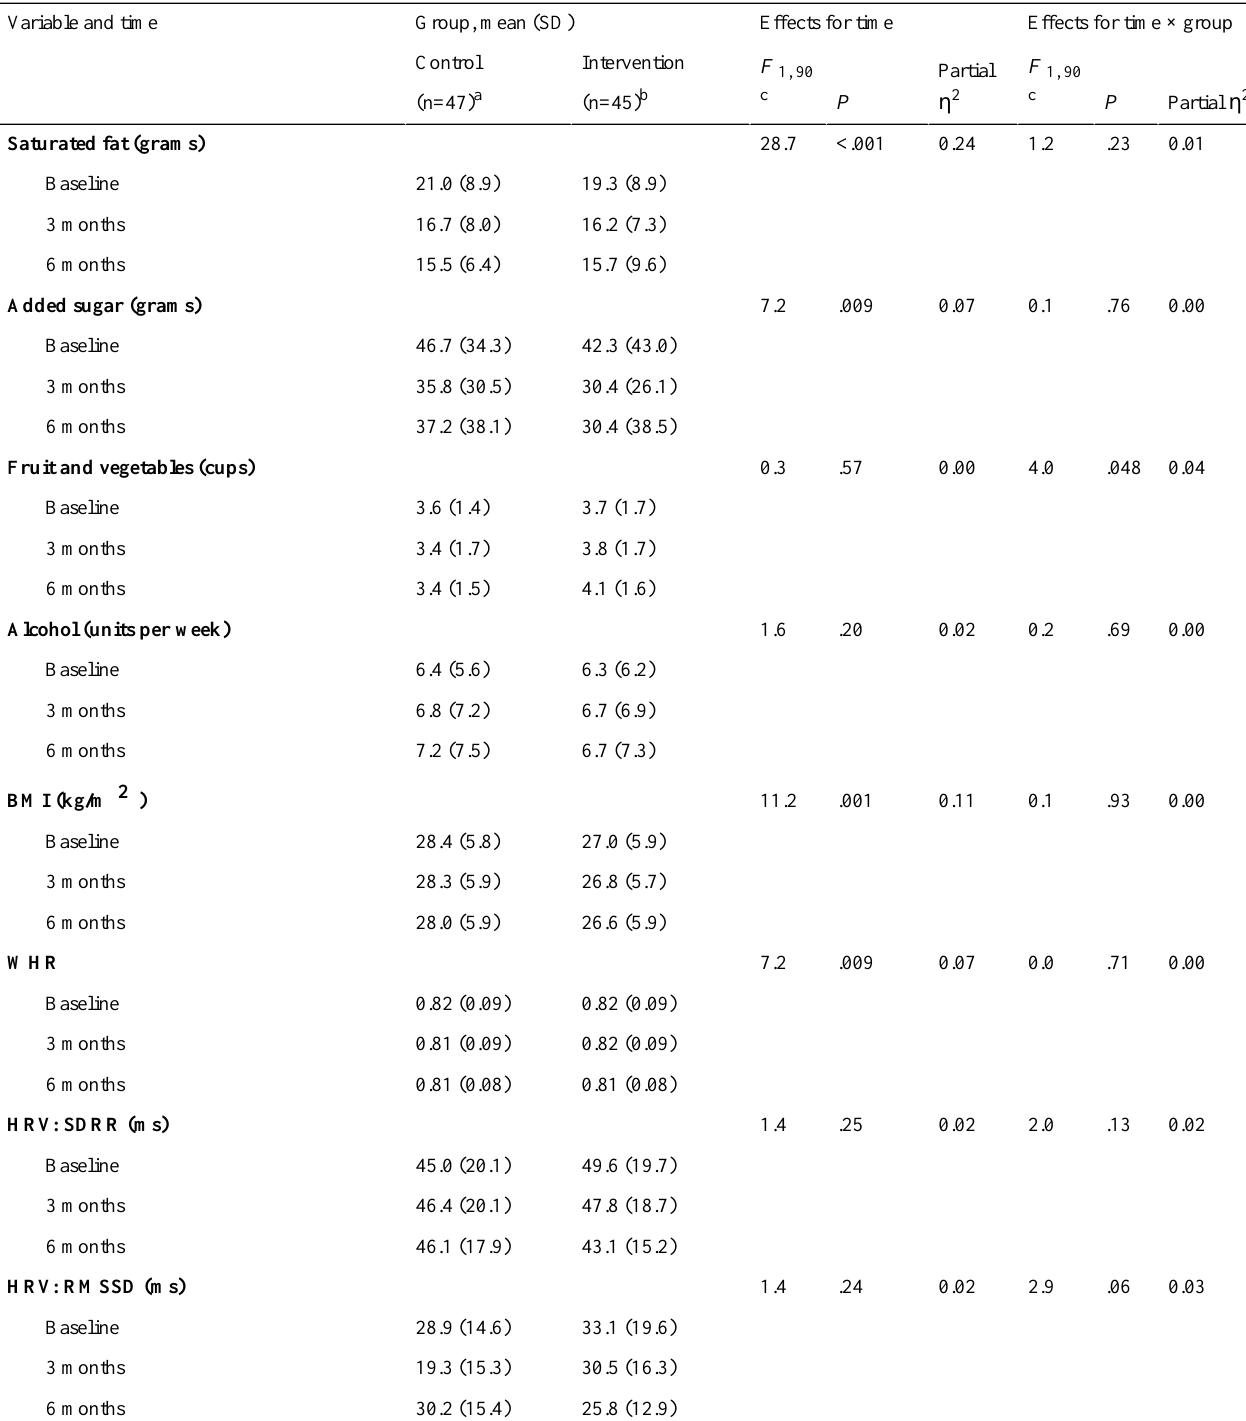
Table 3. Means (SDs) and results from ANOVA models for laboratory-assessed primary and secondary outcomes at baseline, 3 months, and 6 months in the intervention and control groups, for the per protocol analyses.